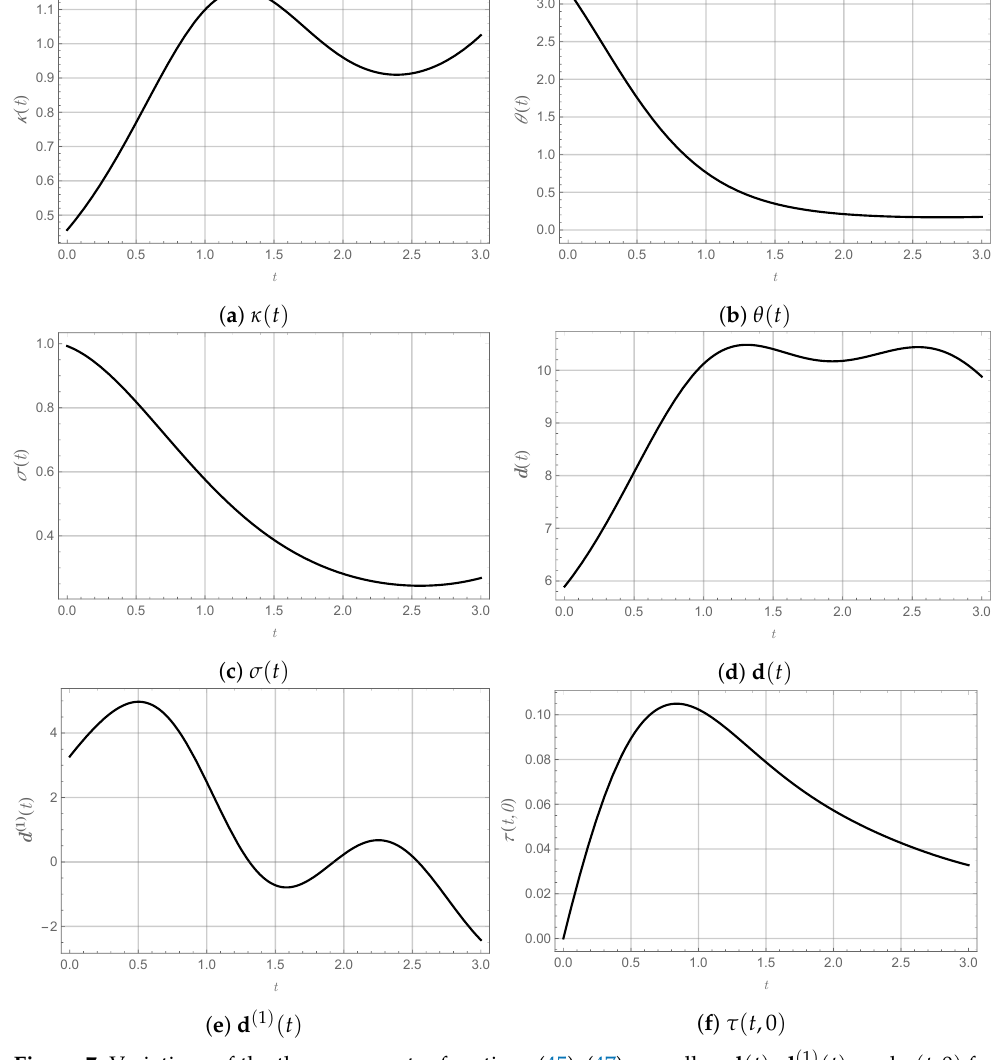
Figure 7. Variations of the three parameter functions (45)–(47) as well as d ( t ) , d ( 1 ) ( t ) , and τ ( t ,0 ) for t ∈ [ 0,3 ] in Example